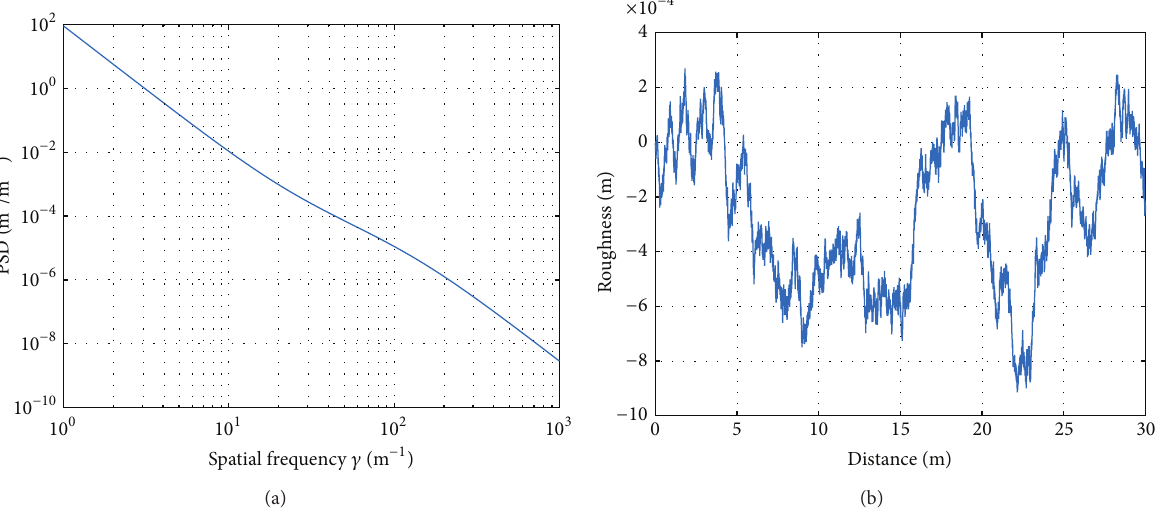
Figure 2: Rail irregularity with respect to (a) PSD and (b)